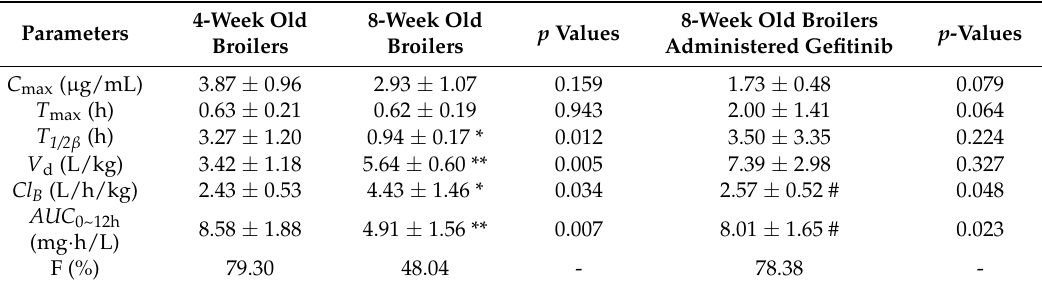
Figure 5. The concentration-time profiles of florfenicol. ( A ) The plasma concentration-time profiles of orally administered florfenicol (20 mg/kg b.w.) in the 4- and 8-week old broilers. ( B ) The plasma concentration-time profiles of intravenous administered florfenicol (10 mg/kg b.w.) in the 4- and 8-week old broilers. All data represent mean ± SD ( n = 5). Table 3. Parameters of florfenicol administrated orally (20 mg/kg) in the 4- and 8-week old broilers (in the presence and absence of gefitinib (100 mg/kg)), respectively.